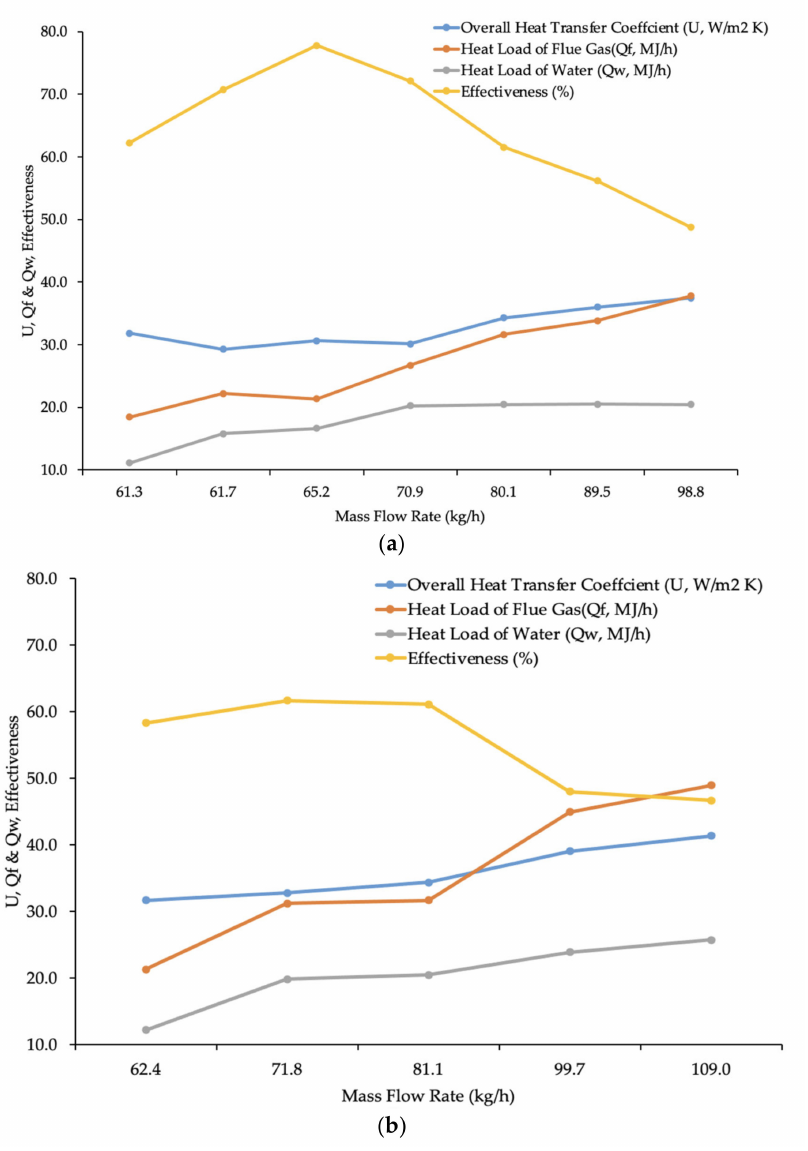
Figure 6. Performance of the STHE under various mass flow rates of flue gas on the shell